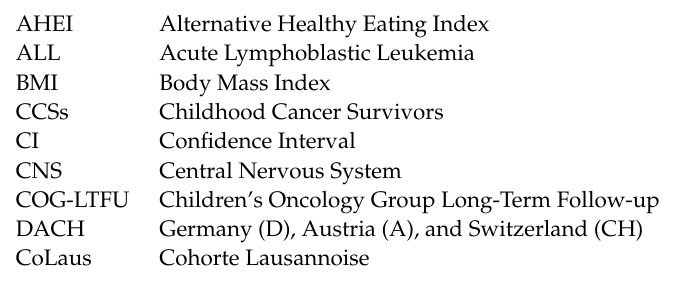
Childhood Cancer Survivor Study (SCCSS)-Nutrition study, Table S1: Clinical characteristics of childhood cancer survivors, Table S2: Dietary intake in childhood cancer survivors and the general population in Switzerland compared to the DACH dietary recommendations, Table S3: Dietary intake in childhood cancer survivors by sex compared to the DACH dietary recommendations, Table S4: Scoring method and mean scores (95%CI) of components of the modified Alternate Healthy Eating Index a, b by sex in childhood cancer survivors and the general population in Switzerland (Bus Sant é and